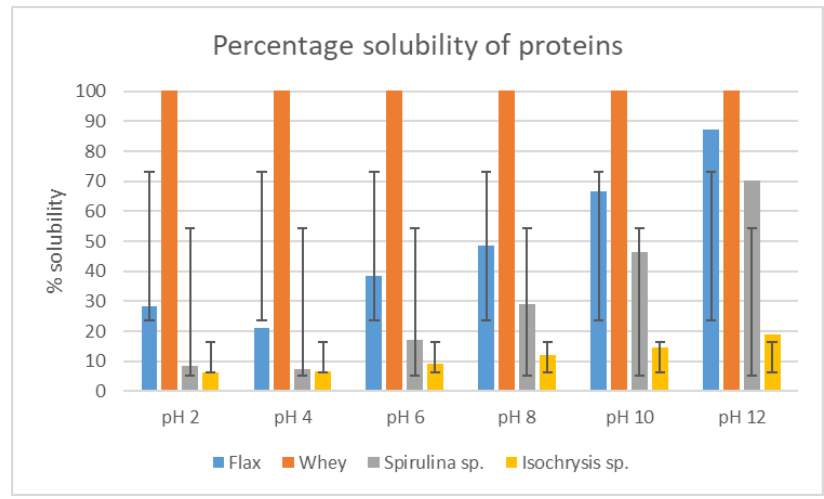
Figure 4. Solubility of extracted proteins at different pH values (n = 3).